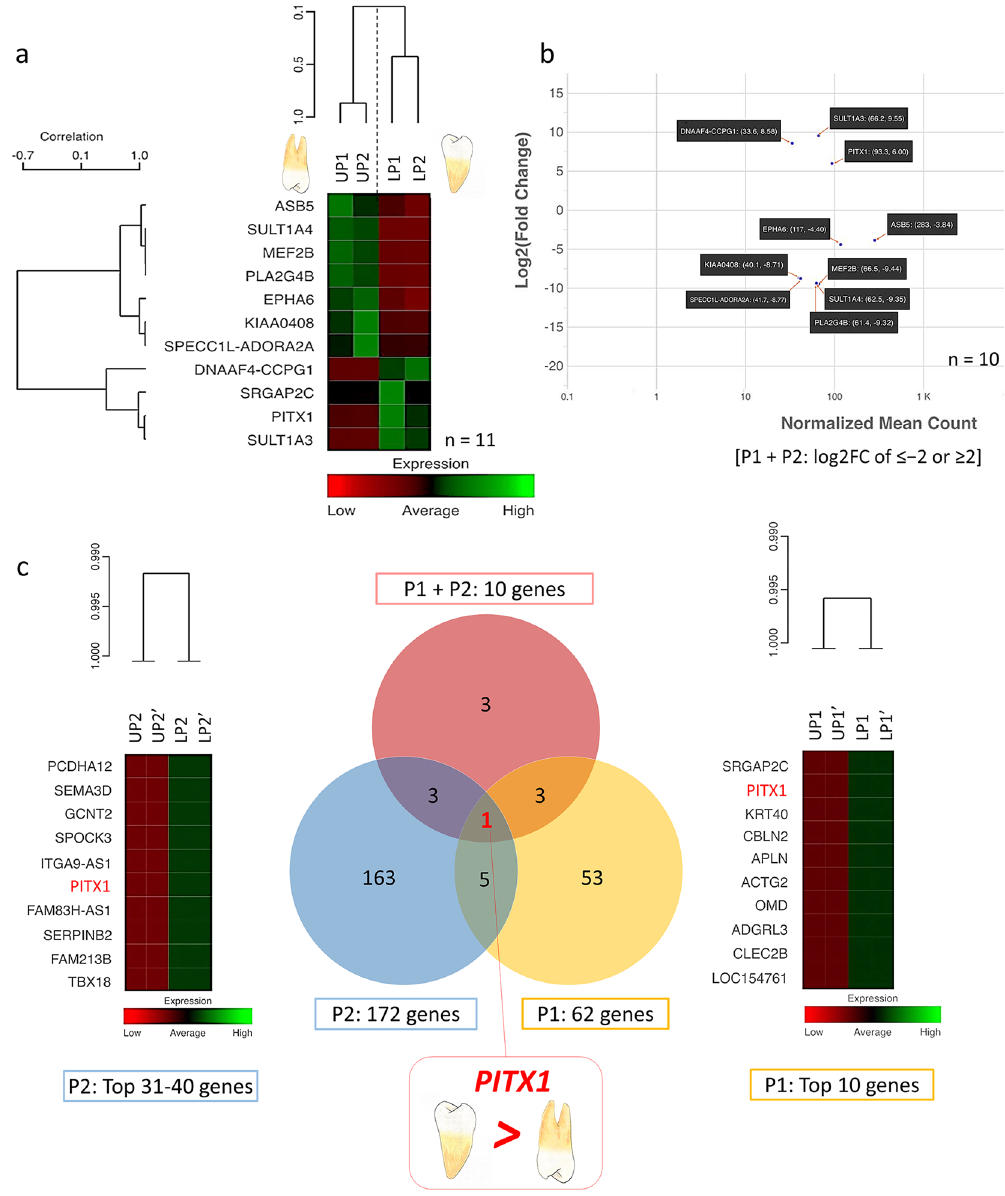
Figure 3. Differential gene expression between upper and lower premolars. ( a ) Heatmap presenting 11 genes having true significance and differential expression between upper and lower premolars in P1 + P2. ( b ) MA-plot showing 10 differential genes with log2FC of ≤ − 2 or ≥ 2. ( c ) Venn diagram of differential expression genes between upper and lower premolar teeth showing that only PITX1 had significantly higher expression in the lower premolars compared with the upper premolars in all sets of premolar